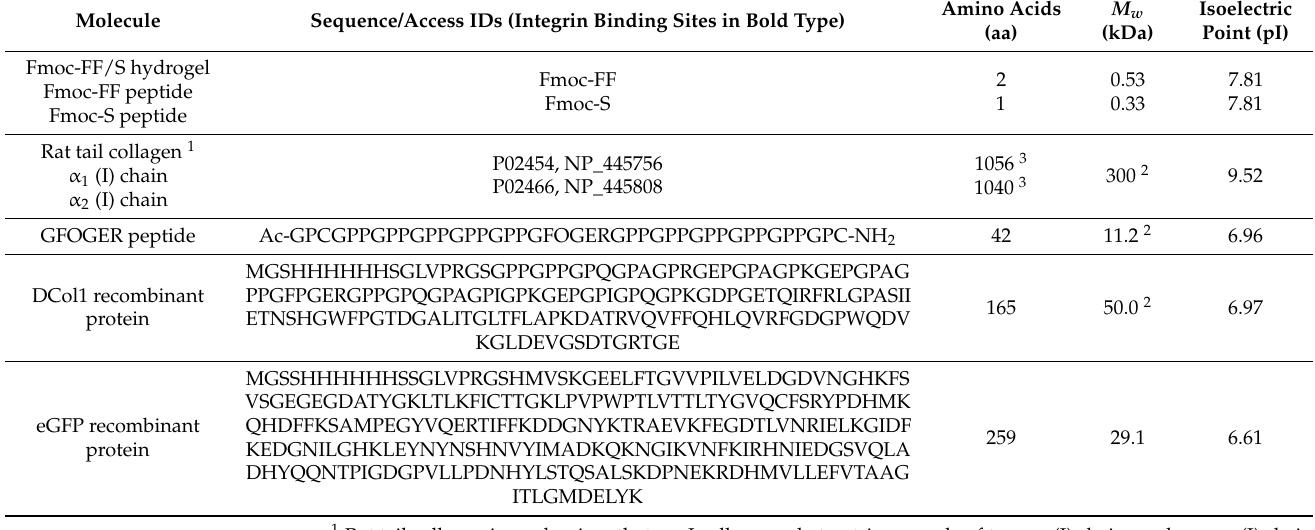
Table 1. Proteins and peptides used for hydrogel formation and modification. Sequences are shown with standard single amino acid symbols, plus O for 4-hydroxyproline. Capping groups: